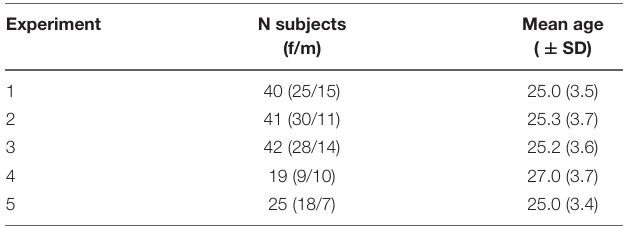
TABLE 1 | The number of subjects per experiment is given in total and separately per gender.